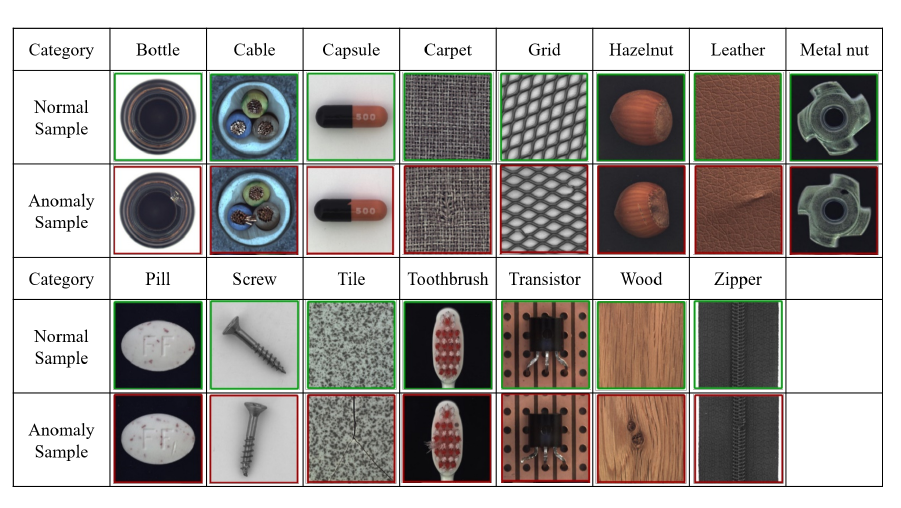
Figure 4. MVTec AD dataset for industrial